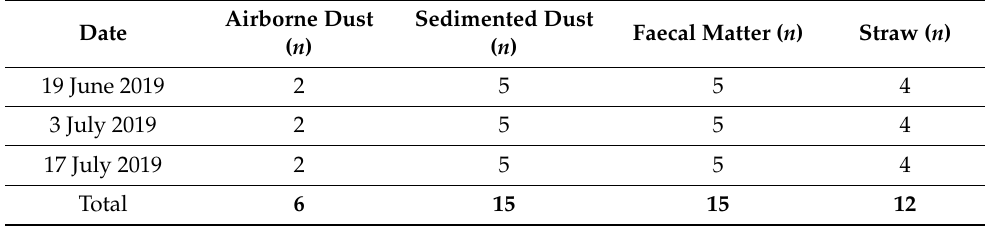
Table 1. The number of material samples taken on each day from the airborne dust, sedimented dust, faecal matter, and straw. Airborne Dust Sedimented Dust Faecal Matter ( n ) Straw ( n ( n )